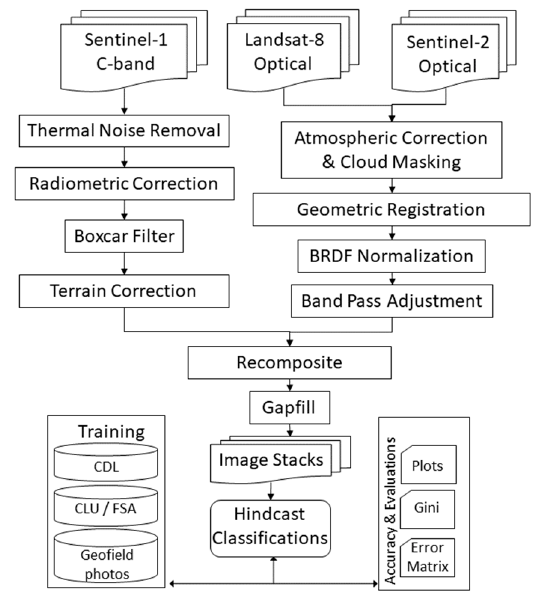
Figure 2. The conceptual workflow fusing multitemporal radar and optical moderate resolution imagery. Table 1. The moderate resolution Earth observation inputs for crop classifier.